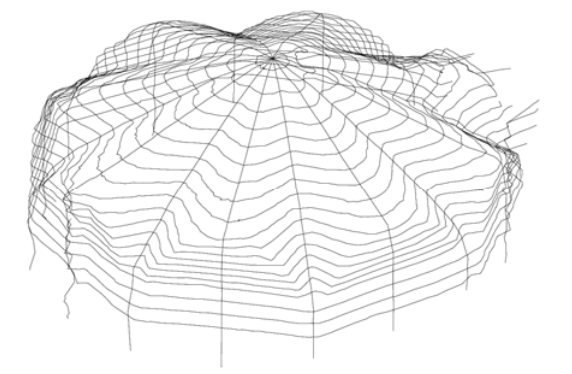
Figure 5. Horizontal and radial sections of the points cloud.